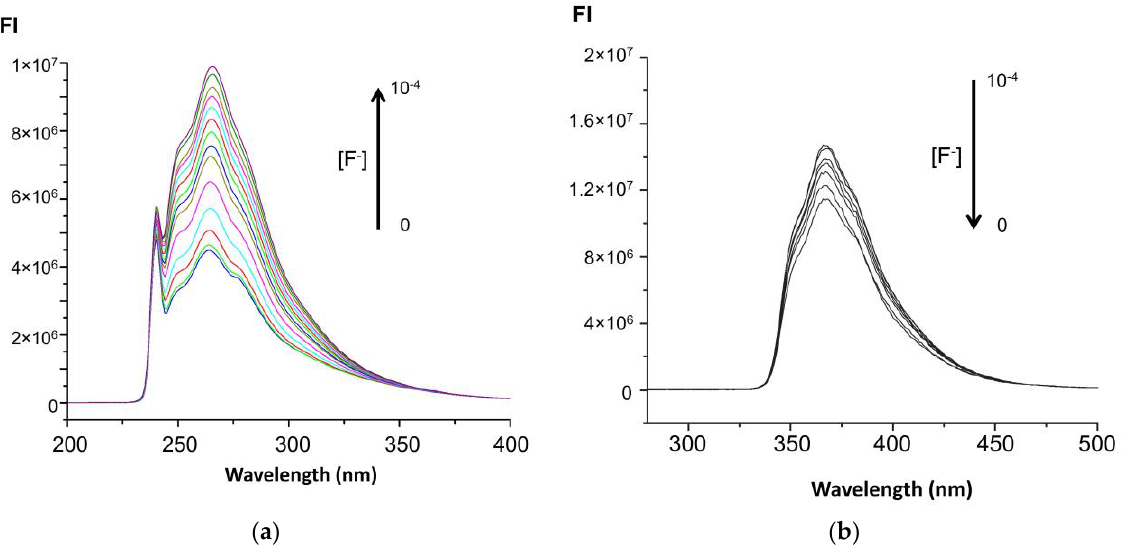
Figure 4. Overlaid fluorescence emission spectra of 2c in acetone ( a ) (λ ex = 340 nm) and in ethanol ( b ) (λ ex = 290 nm), in the presence of increasing concentrations of fluoride anion. FI: fluorescence intensity in arbitrary units. Wavelength in nm.